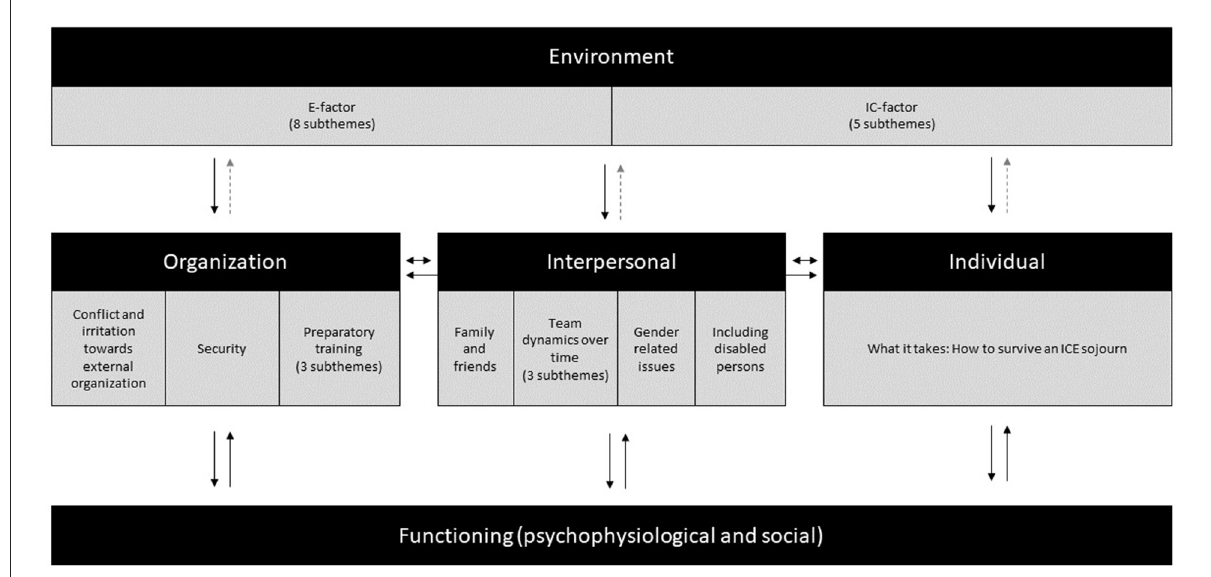
FIGURE2 Human behavior and performance model, illustrating how the ICE-environment shapes the impact of organizational, interpersonal, and individual systems, thus influencing the function of sojourners. We interpreted the impact of the environment with its IC- and E-factor as (quasi) unidirectional, hence the dotted line to indicate that potentially, under exceptional circumstances, the other factors might back influence the